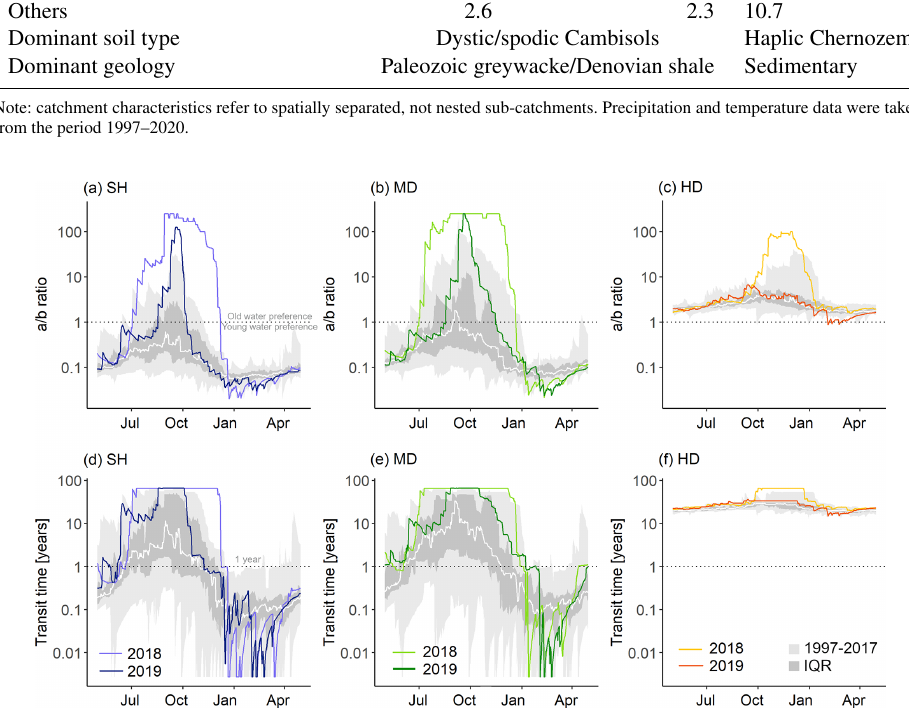
Figure 5. Simulated sub-catchment-specific water age selection preference (a–c) as the ratio of the fitted parameters a and b , and (d– f) median transit times are given in years. Grey areas indicate the range of all years previous to the drought (1997–2017, with a year starting in May), and their interquartile range and white lines are the median of all pre-drought years. Colored lines indicate the 2-year drought, with the 2 years starting in May 2018 and